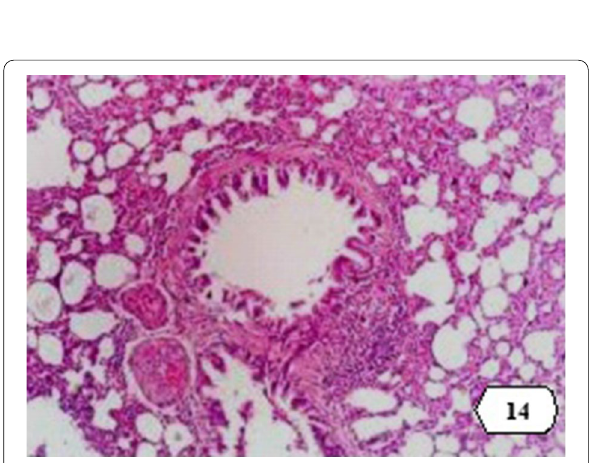
Fig. 14 Lung tissue image of Ch-NPs diffused focal proliferation of inflammatory cells associated with fibrous tissue proliferation (hematoxylin and eosin magnification)